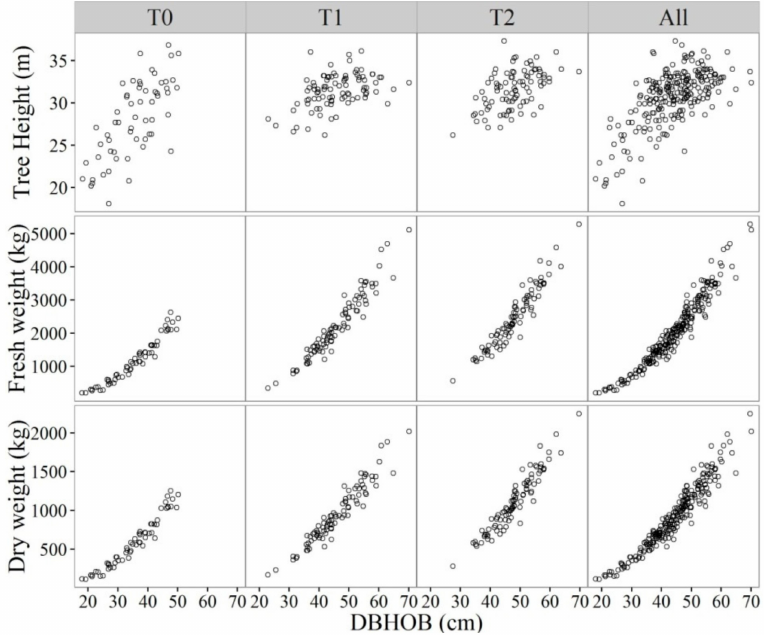
Figure 2. Total height, fresh and dry weight of sample trees plotted against their diameter at breast height overbark (DBHOB) for unthinned (T0), once- and twice-thinned (T1 and T2) stands and for all data combined